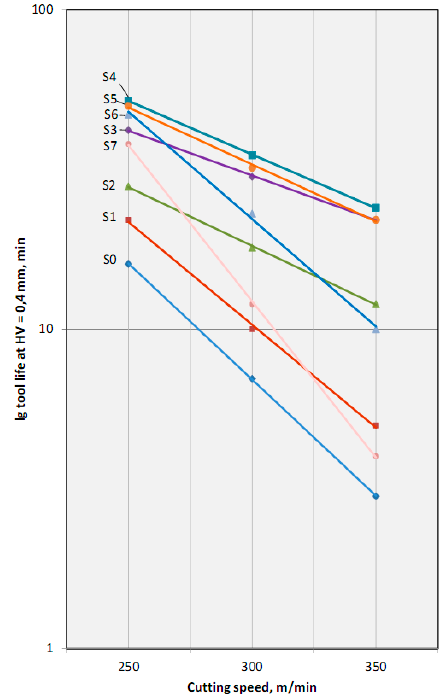
Figure 16. Speed–wear resistance relationship during longitudinal rotation of steel C45 ( f = 0.25 mm / rev, a p = 1 mm, and v c = 250, 300, and 350 m /